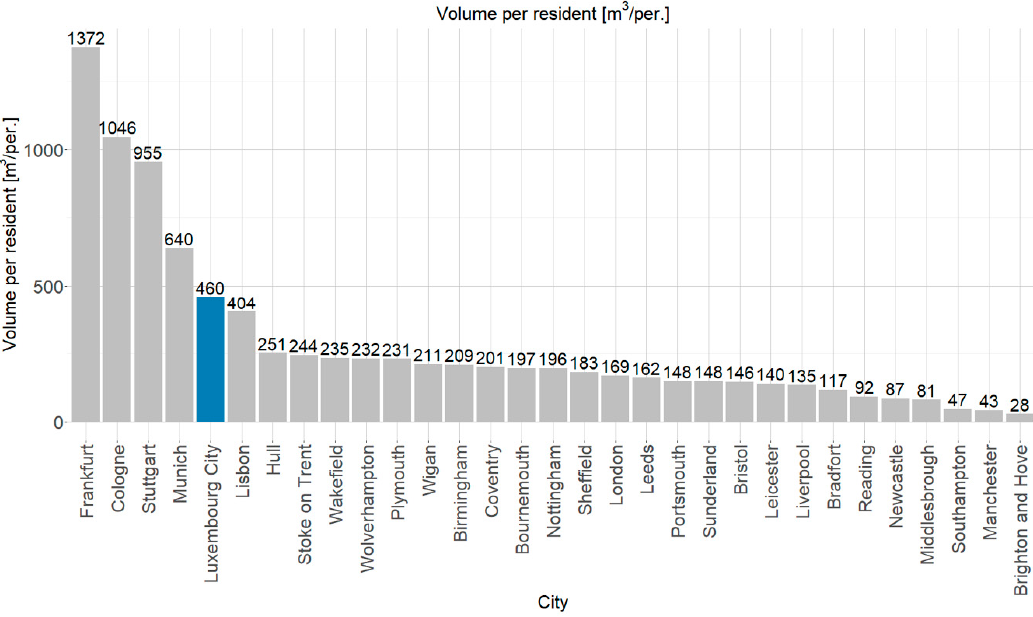
Figure 18. Volume of buildings per resident in European cities (Source: based on data in publication [44,45,54]).